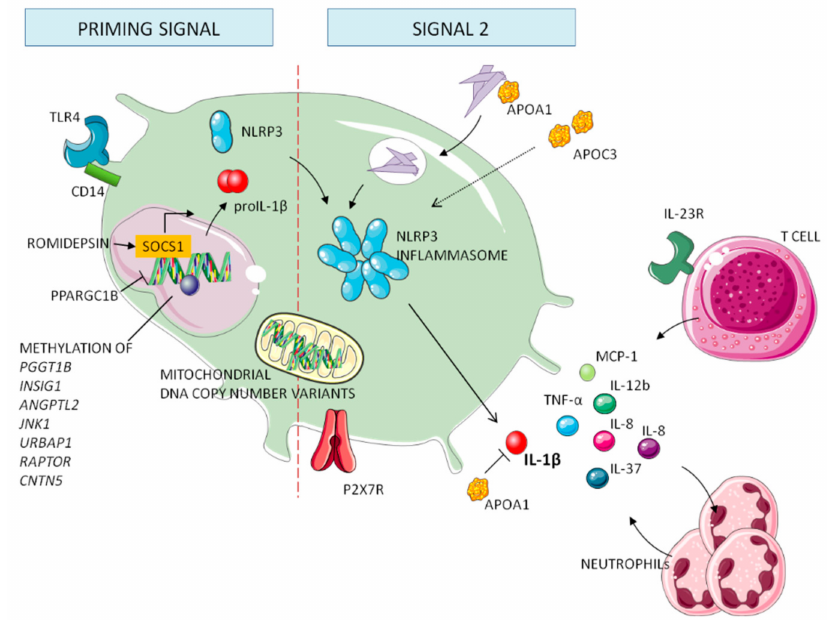
Figure 3. Genes involved in initiating the inflammatory response to MSU crystals. Many loci code for proteins involved in the inflammasome pathway; however, some mitochondrial and epigenetics factors have been reported to be associated with the inflammatory regulation of gouty